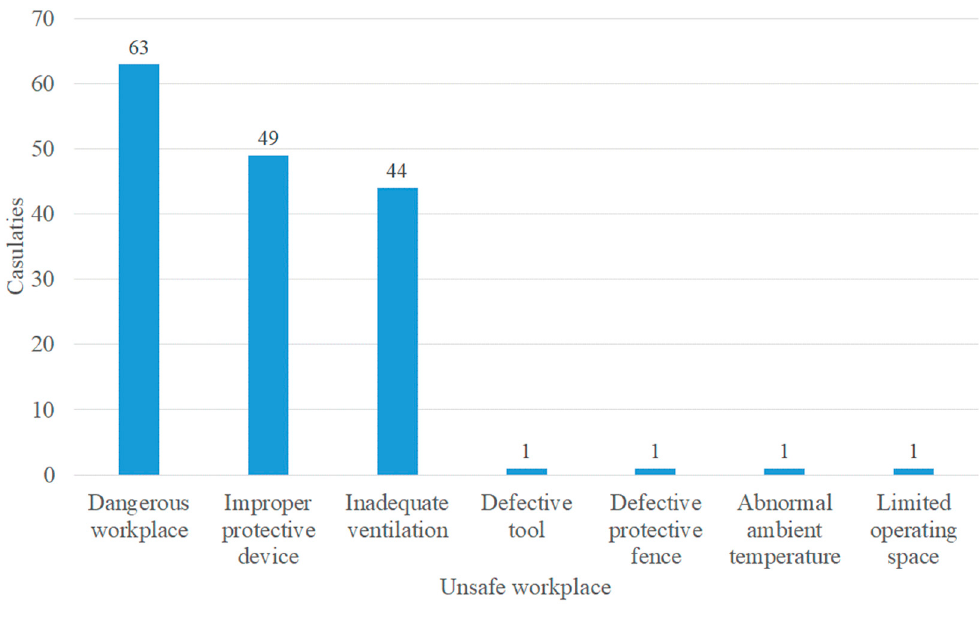
Figure 5. Statistics for non-standard conditions.